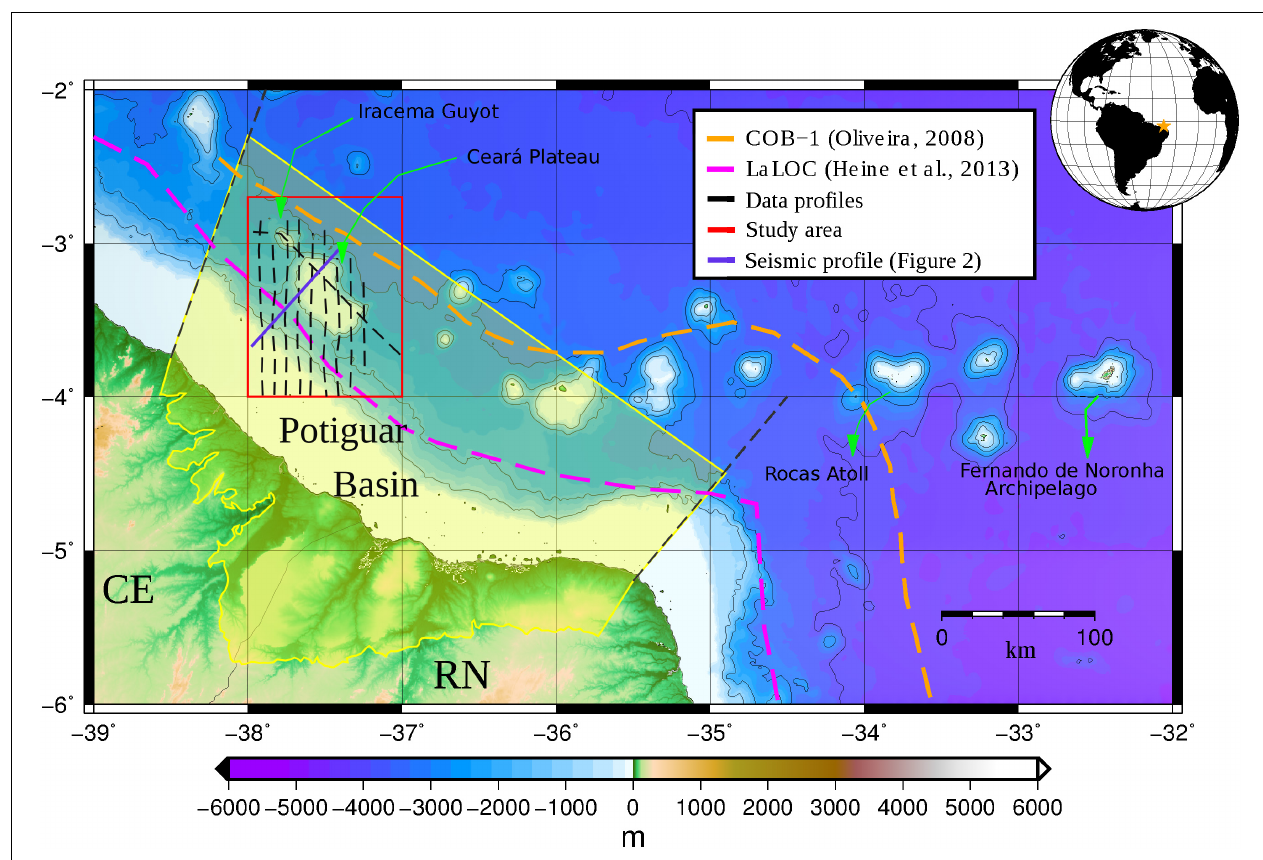
FIGURE 1 | Brazilian Equatorial Margin topobathymetric map. The red rectangle indicates the study area. Bathymetric contours shown at 1000 m intervals. MA: Maranhão state, PI: Piauí state, CE: Ceará state, RN: Rio Grande do Norte state. Topobathymetric data by SRTM15PLUS (Shuttle Radar Topography Mission) 15 arc-sec resolution (Olson et al., 2014).